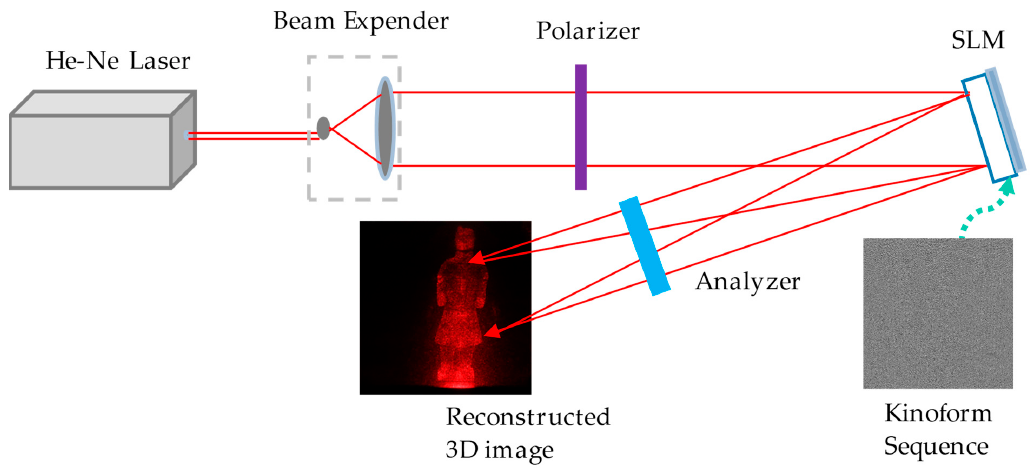
Figure 9. Experimental setup for dynamic 3D electro-optical reconstruction.